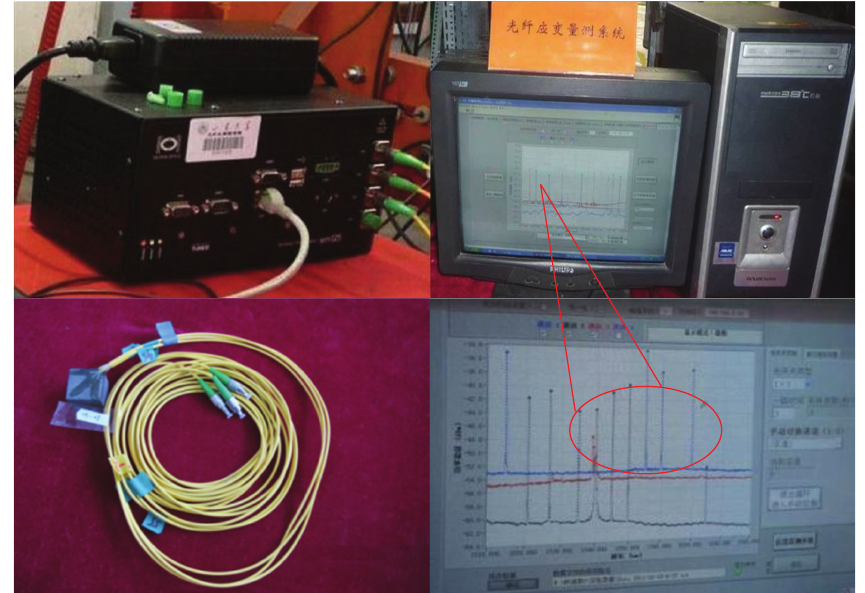
Figure 7: Grating strain sensor measuring